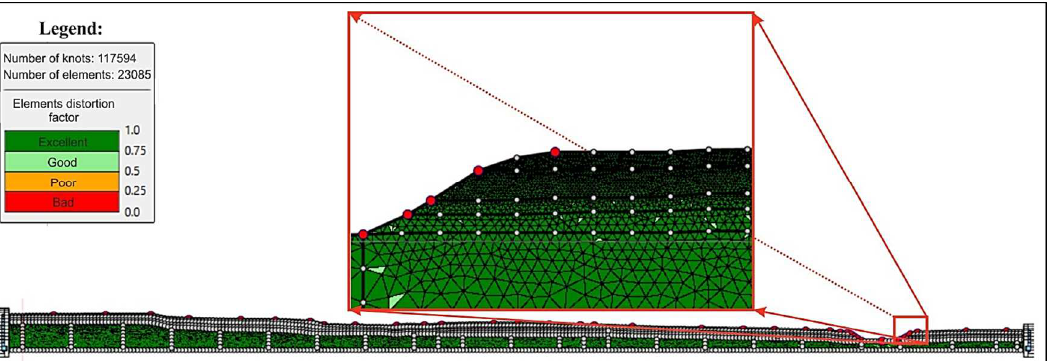
Figure 8. Mesh pattern, number of knots and elements of the 2D numerical model (BB’ section).